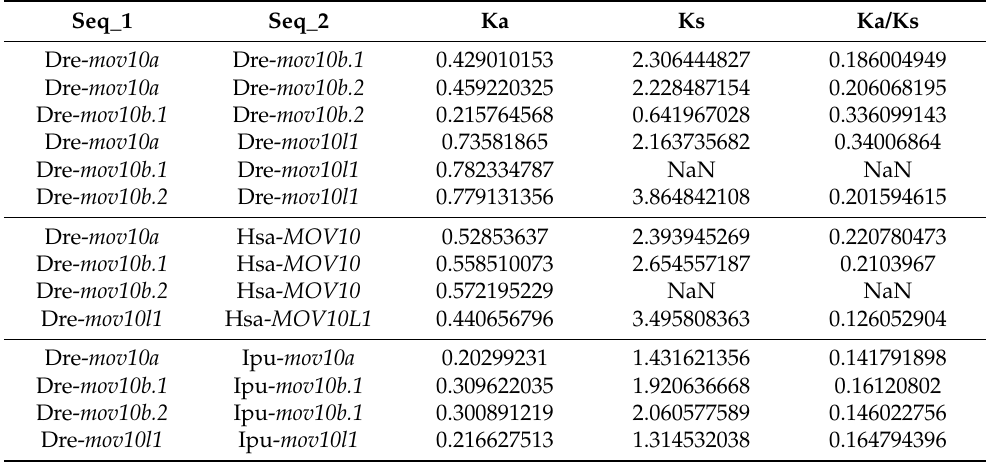
Table 3. The Ka/Ks ratios of the MOV10 and MOV10L1 genes in zebrafish and other three repre- sentative species.